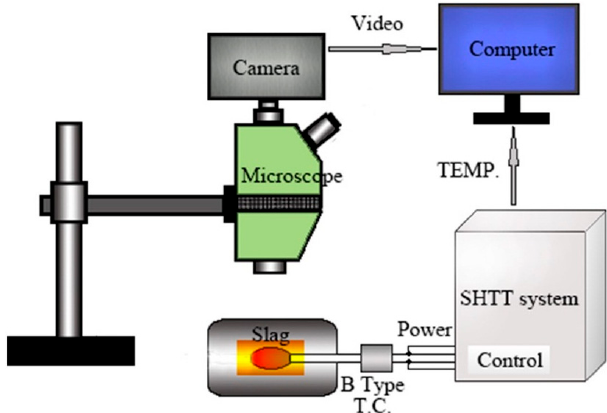
Figure 6. The schematic of Single Hot Thermocouple Technique (SHTT) experimental apparatus.